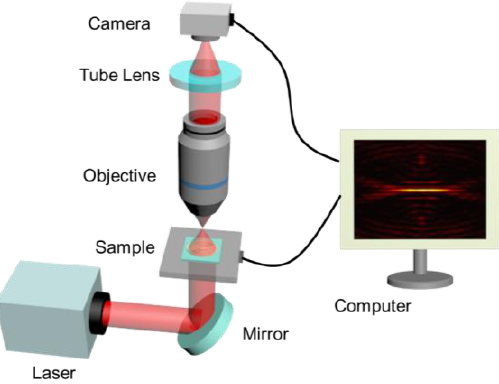
Figure A4. Schematic illustration of the optical characterization system.